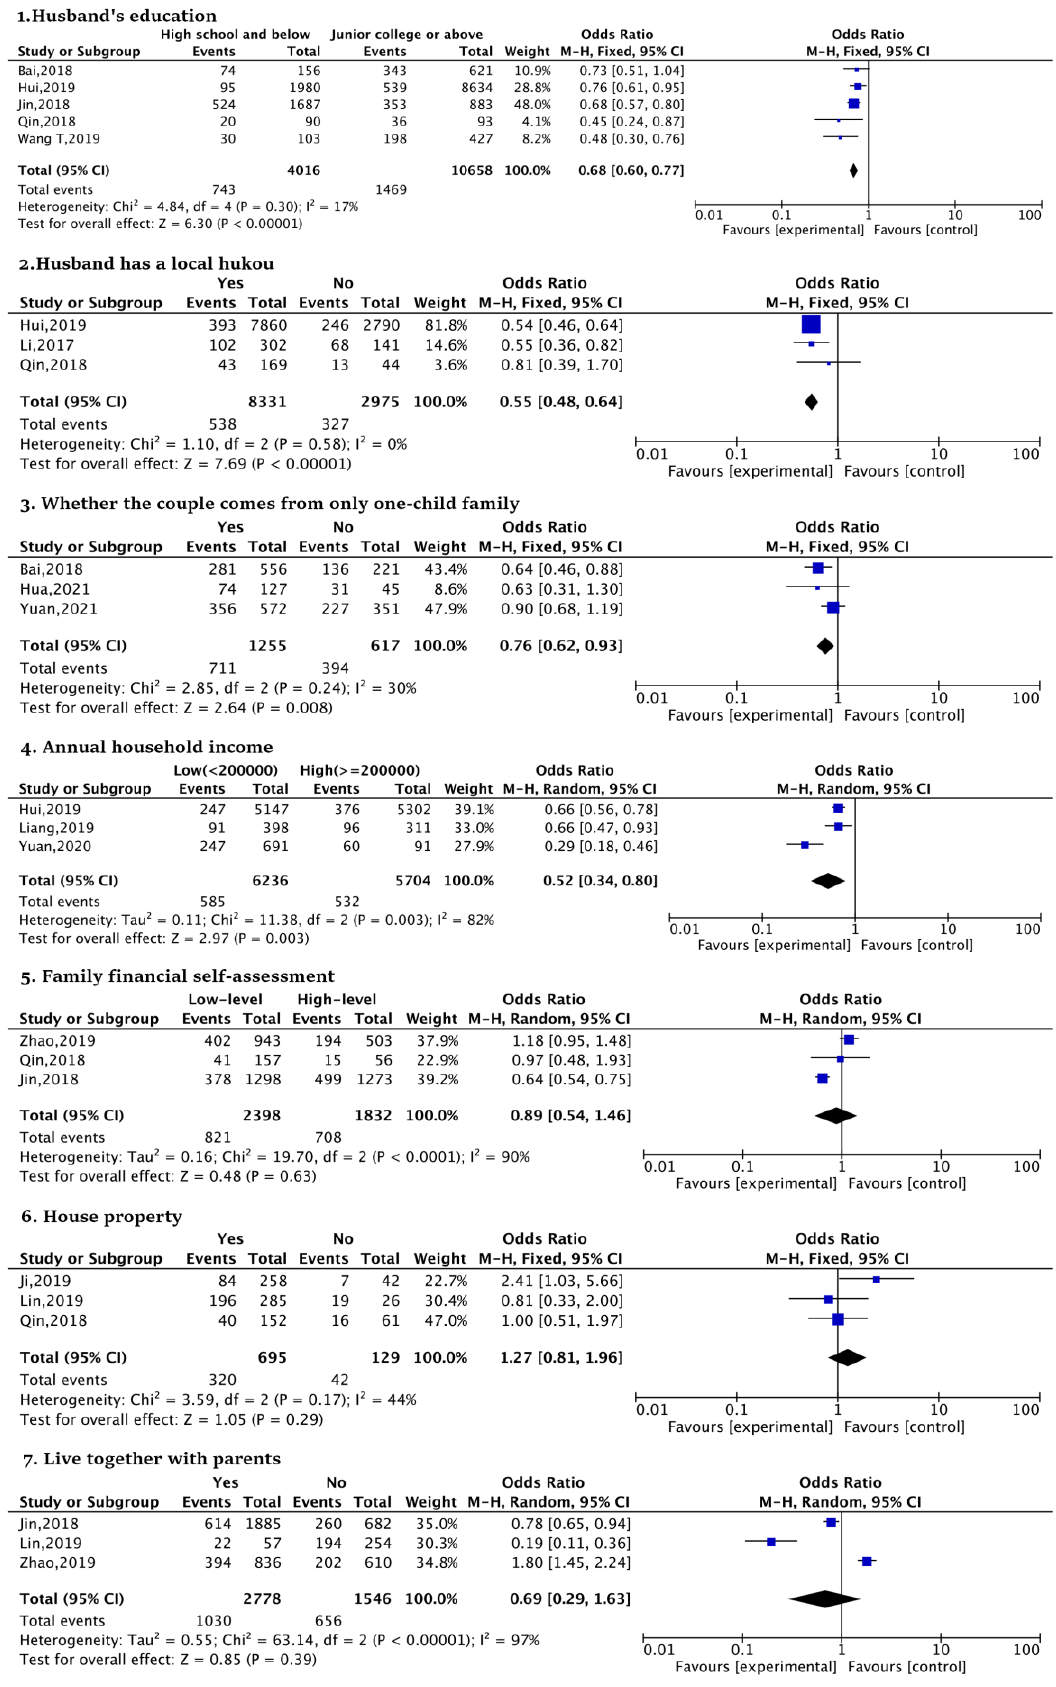
Figure 4. Forest plots of husband factors.